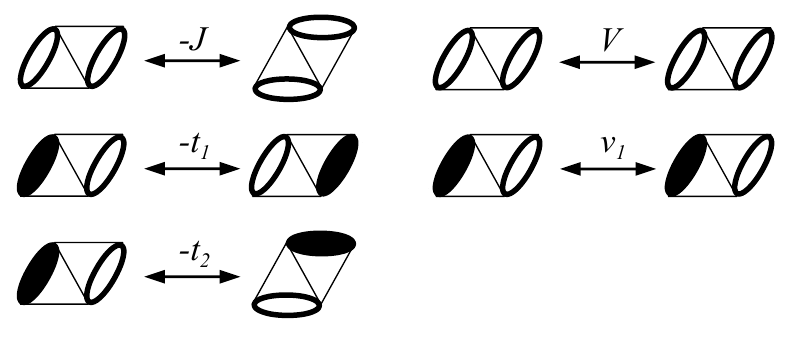
Figure 3: Definition of plaquette terms appearing in our Hamiltonian in Eq. (3) and their respective transition amplitudes. Equivalent terms on the other two elementary plaquettes indicated in Fig. 2 as well as symmetry related terms are not